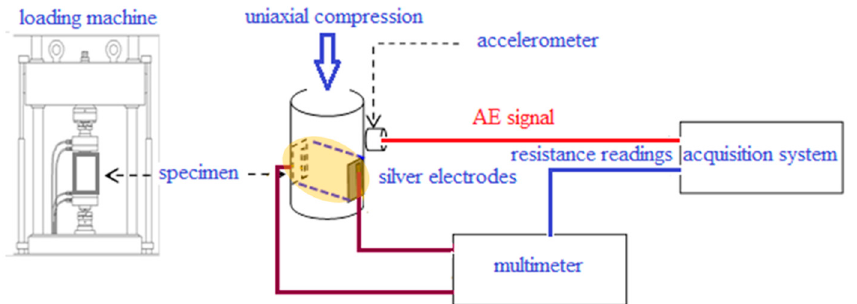
Figure 1. Experimental setup (the yellow region between the electrodes, marked by a dotted outline, defines the volume through which most of electric charges are expected to flow). Adapted from [44].